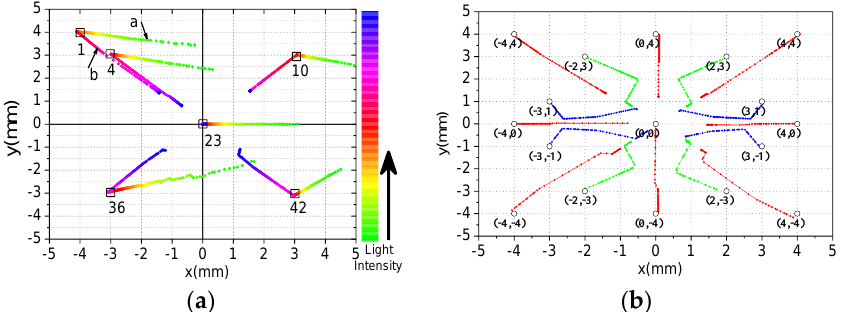
Figure 9. ( a ) Spot location coordinates with varying light intensity; ( b ) spot location coordinates at saturation.